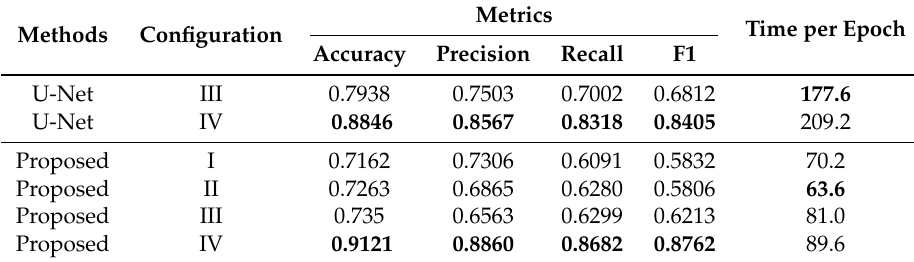
Table 7. Comparison between single polarization, single date and multi date in terms of all metrics.